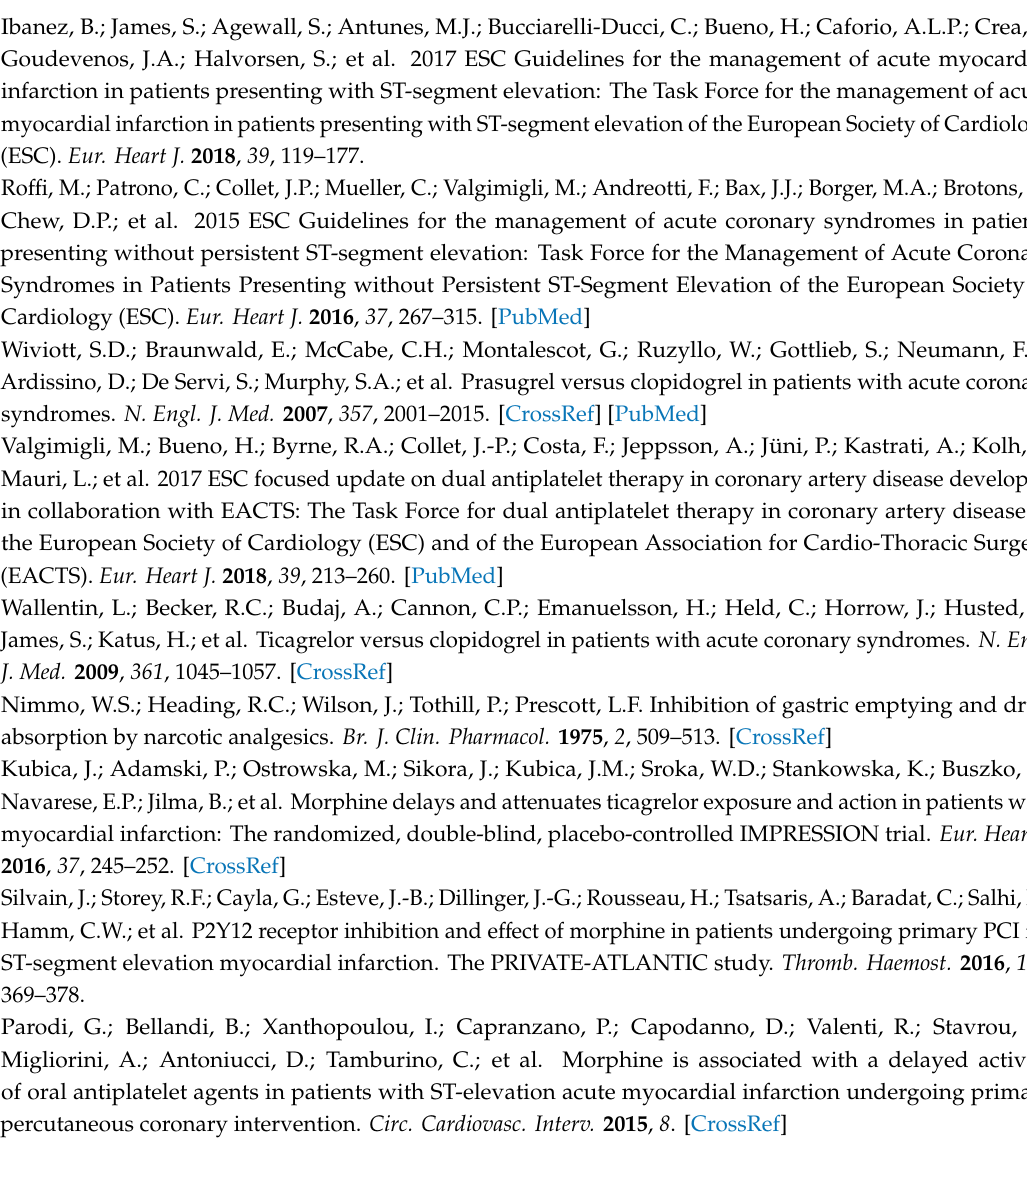
Figure S1A and Figure S1B: Kaplan–Meier event curves with landmark analysis from 30 days (A) and two months (B)